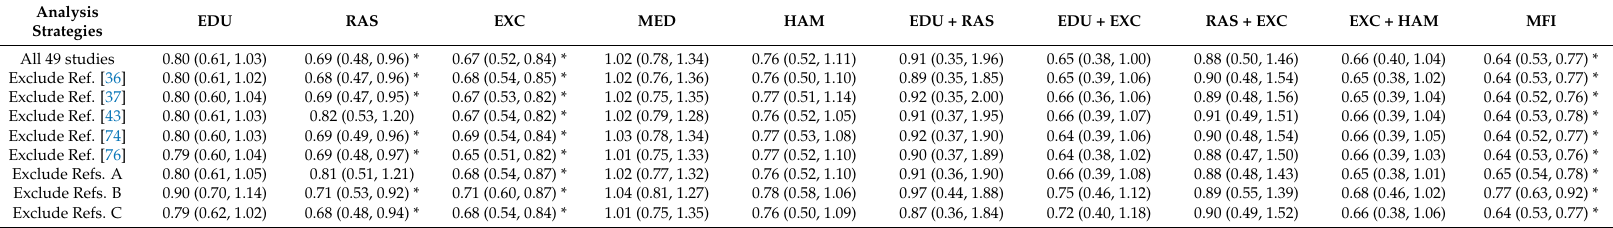
Table 2. Changes in pooled odds ratios of ten comparator groups in comparison to usual care after excluding studies with high-risk biases or unclear biases. Analysis Strategies EDU RAS